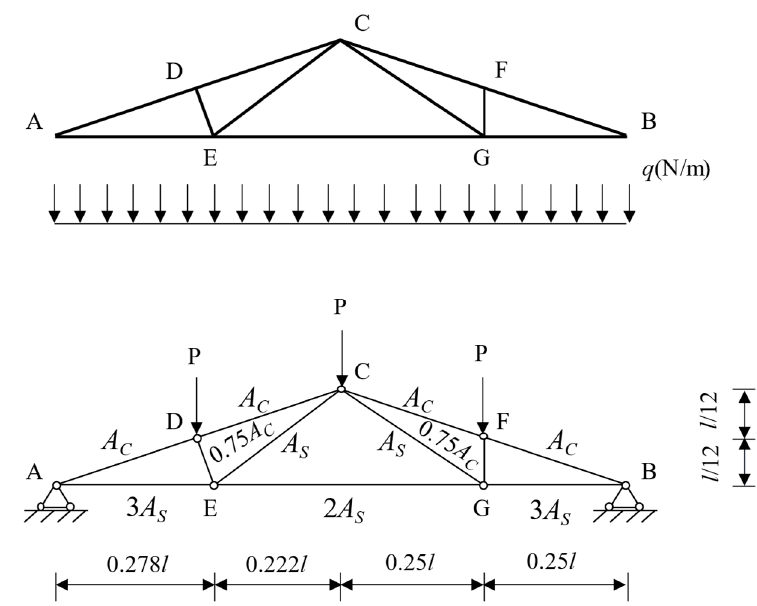
Figure 7. Configuration of roof